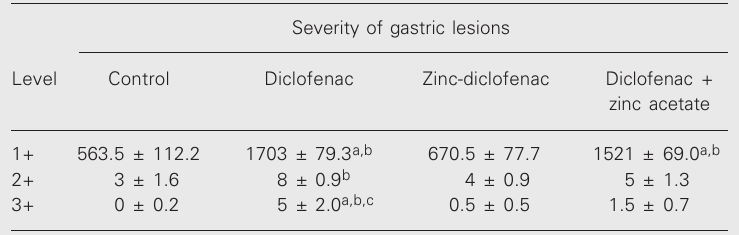
Table 3. Effect of diclofenac, zinc-diclofenac, and diclofenac plus zinc acetate on gastric lesions after intraperitoneal